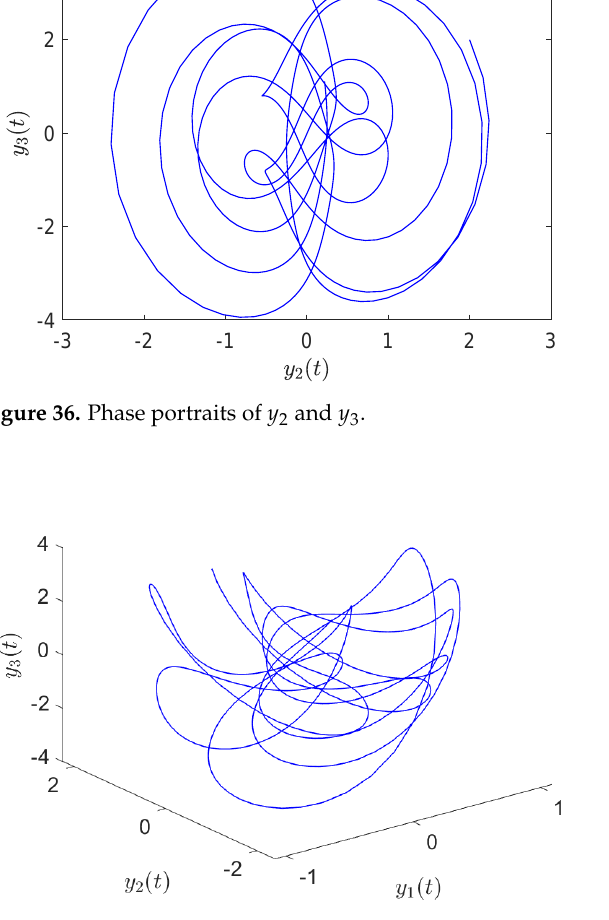
Figure 37. Phase portraits of y 1 , y 2 and y 3